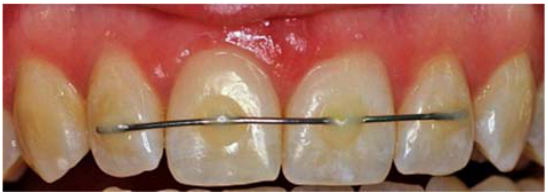
Figure 1. The wire ‐ composite splint. Figure 1. The wire-composite splint.